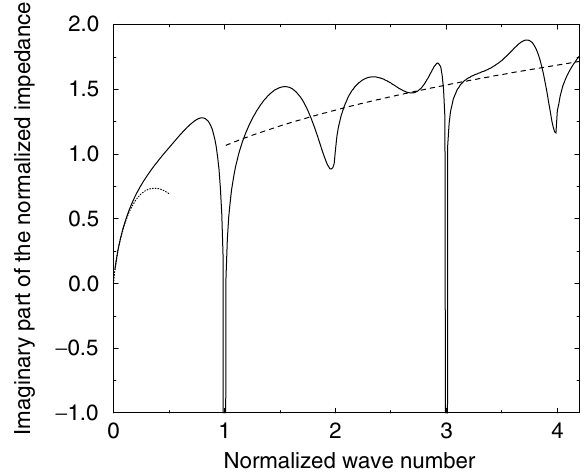
FIG. 2. Plot of (cid:13) FF (cid:5) (cid:22) (cid:6) of Eq. (21).